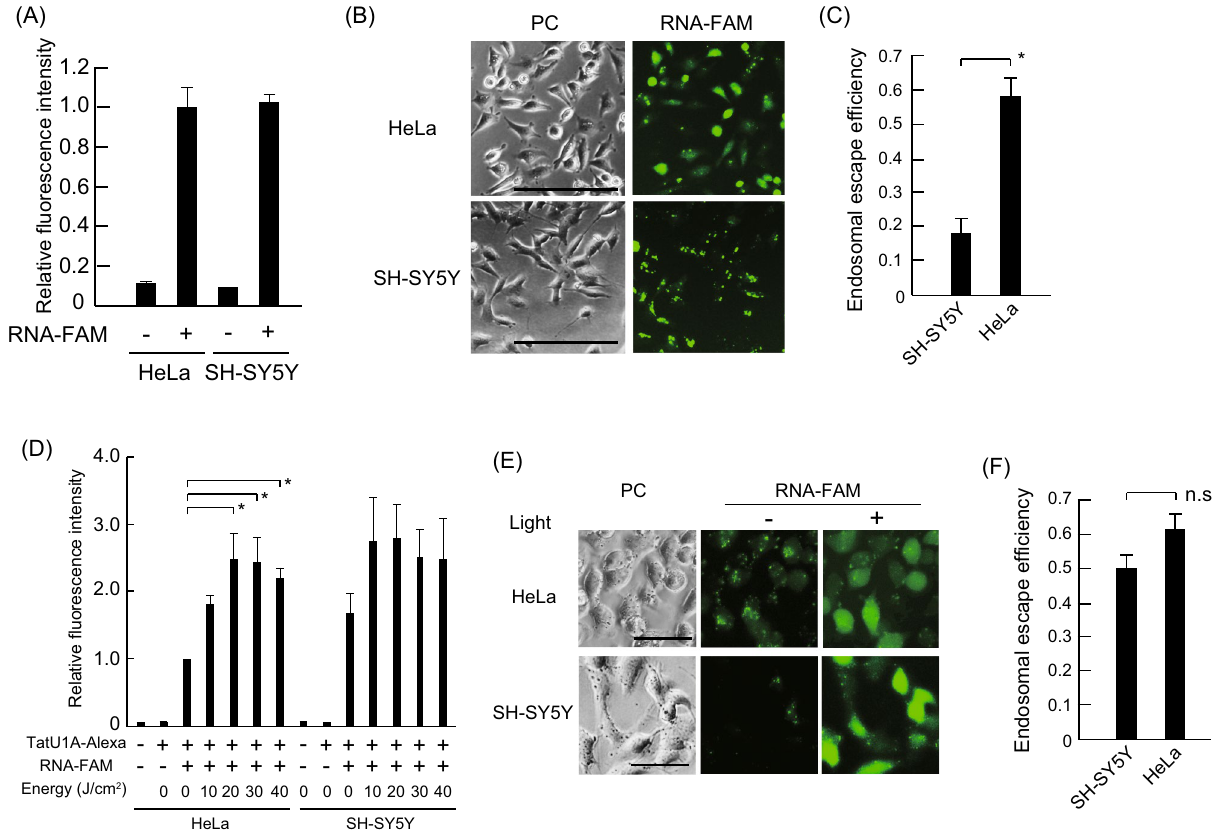
Figure 5. RNA-FAM incorporation in the cytosol using Lipofectamine 3000 and photoinduced cytosolic dispersion of RNA (PCDR). ( A ) The fluorescence intensity of RNA-FAM delivered into SH-SH5Y and HeLa cells using Lipofectamine 3000 was measured using flow cytometry. Data represent the means ± SEM of three independent experiments. The fluorescence intensity of HeLa cells transfected with RNA-FAM was defined as 1.0. ( B ) RNA-FAM was transfected into SH-SY5Y and HeLa cells using Lipofectamine 3000. RNA-FAM images were obtained after transfection. PC phase contrast images. Scale bars indicate 100 µm. ( C ) The endosomal escape efficiencies of RNA-FAM were calculated by counting the number of the cells in which FAM fluorescence was dispersed within the cytosol (N F ) and the number of the cells (N T ). The endosomal escape efficiency was defined as N F /N T . Data represent the means ± SEM of four independent experiments. *P < 0.05; P-values were calculated using one-way ANOVA and Dunnett’s test. (D) The fluorescence intensity of RNA-FAM delivered by PCDR into SH-SH5Y and HeLa cells was measured using flow cytometry. The fluorescence intensity of HeLa cells irradiated at 0 J/cm 2 was defined as 1.0. Data represent the means ± SEM of five independent experiments. *P < 0.05; P-values were calculated using one-way ANOVA and Tukey’s test. ( E ) RNA-FAM was delivered by PCDR into the cytosol of SH-SY5Y and HeLa cells. RNA-FAM images were obtained before and after photoirradiation. SH-SY5Y and HeLa cells were irradiated at 30 J/cm 2 and 20 J/cm 2 , respectively. PC Phase contrast images. Scale bars indicate 50 µm. ( F ) The endosomal escape efficiencies of TatU1A-Alexa546/RNA complexes were calculated by counting the number of the cells in which FAM fluorescence was dispersed within the cytosol after photoirradiation (N F ) and the number of the cells (N T ). The endosomal escape efficiency was defined as N F /N T . Data represent the means ± SEM of four independent experiments. *P < 0.05, not significant (n.s); P-values were calculated using one-way ANOVA and Dunnett’s